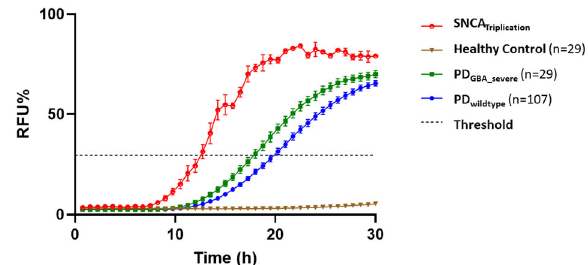
Fig. 3 RT-QuIC positive replicates relative fl uorescence curves at 30 h. RT-QuIC kinetics measured by the mean relative fl uorescence (RFU) of positive curves were most prominent in the SNCA Triplication patient when compared to PD GBA_severe and PD wildtype . He showed the shortest time required to reach the threshold (LAG phase), highest area under the curve (AUC)and the peak of the fl uorescence response (Imax). Each curve represents the average of the group, error bars indicate standard deviation, and the black dashed line indicates the threshold for positive seeding. Relative fl uorescence unit (RFU) values are normalized to percentage against